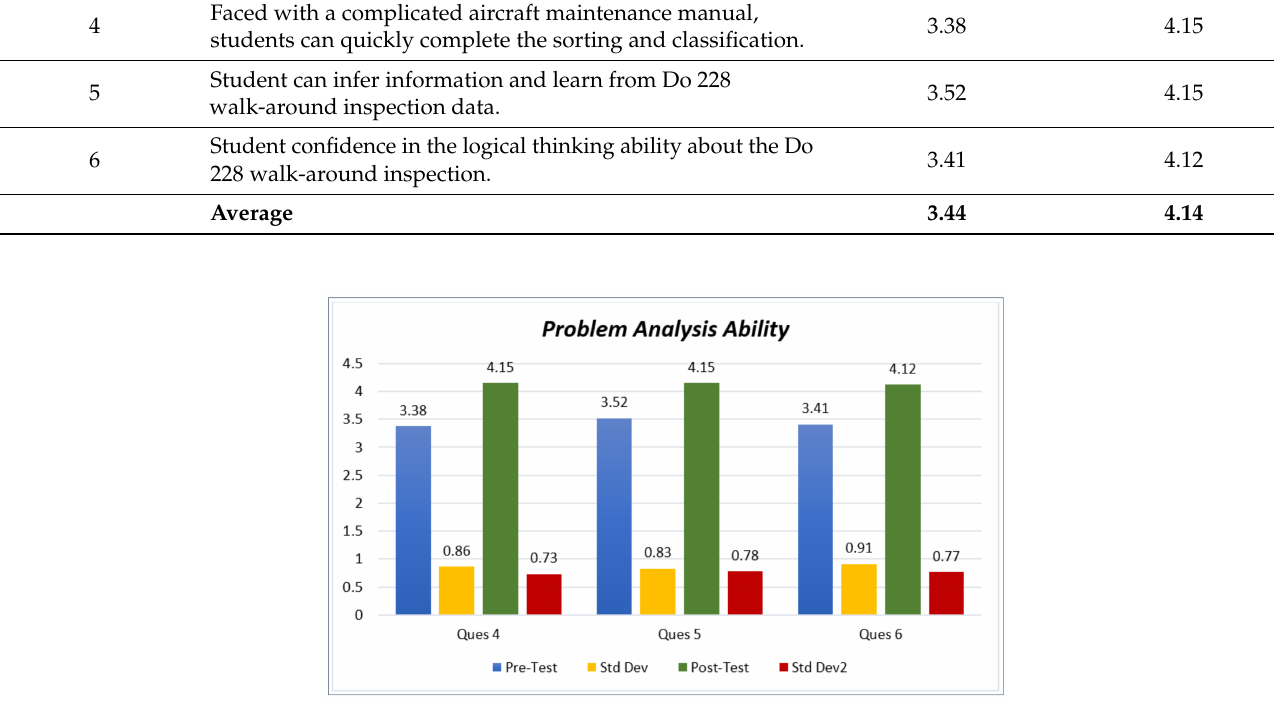
Figure 9. Students’ problem analysis ability in the previous test and the post-test.